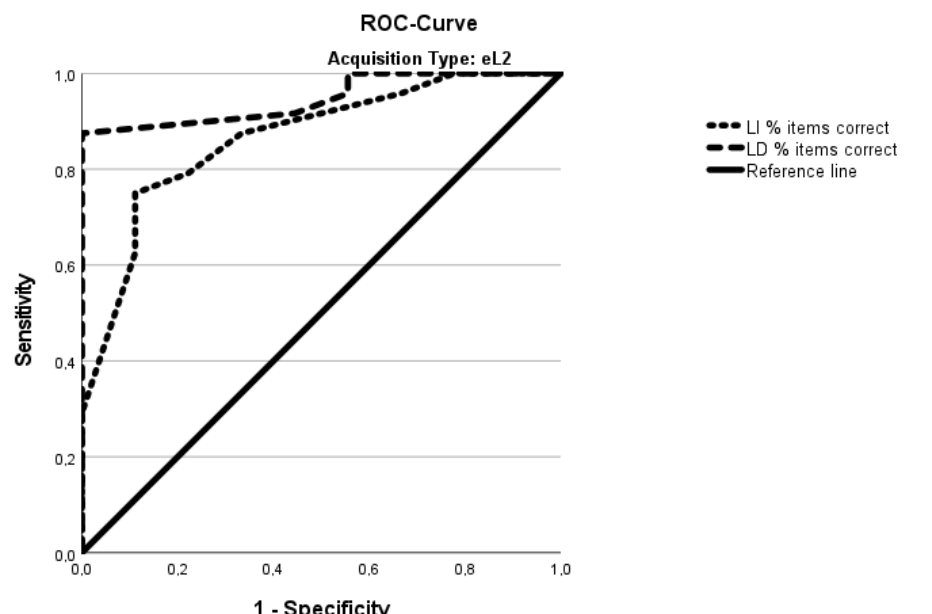
Figure 2. ROC curves for the language-independent (LI) and the language-dependent (LD) part for the eL2 group.